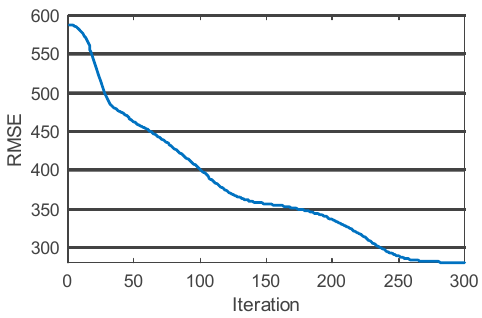
Figure 16. Training progress of the LSTM. The total computing time of the 300 iterations with the LSTM algorithm was 348